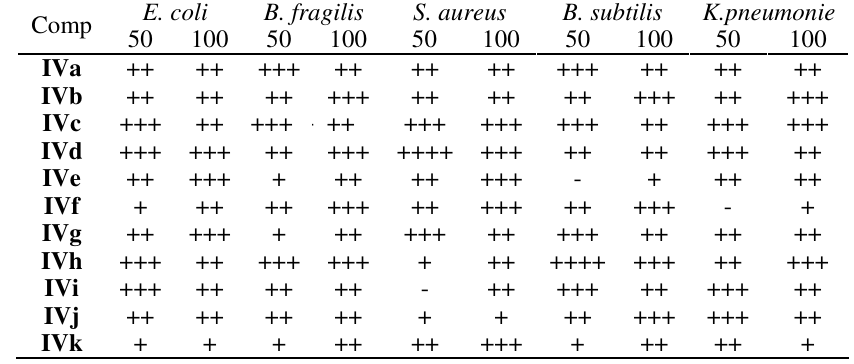
Table 5. Antibacterial activity of the synthesized IV(a-k) against various bacteria at two different concentrations (ppm)